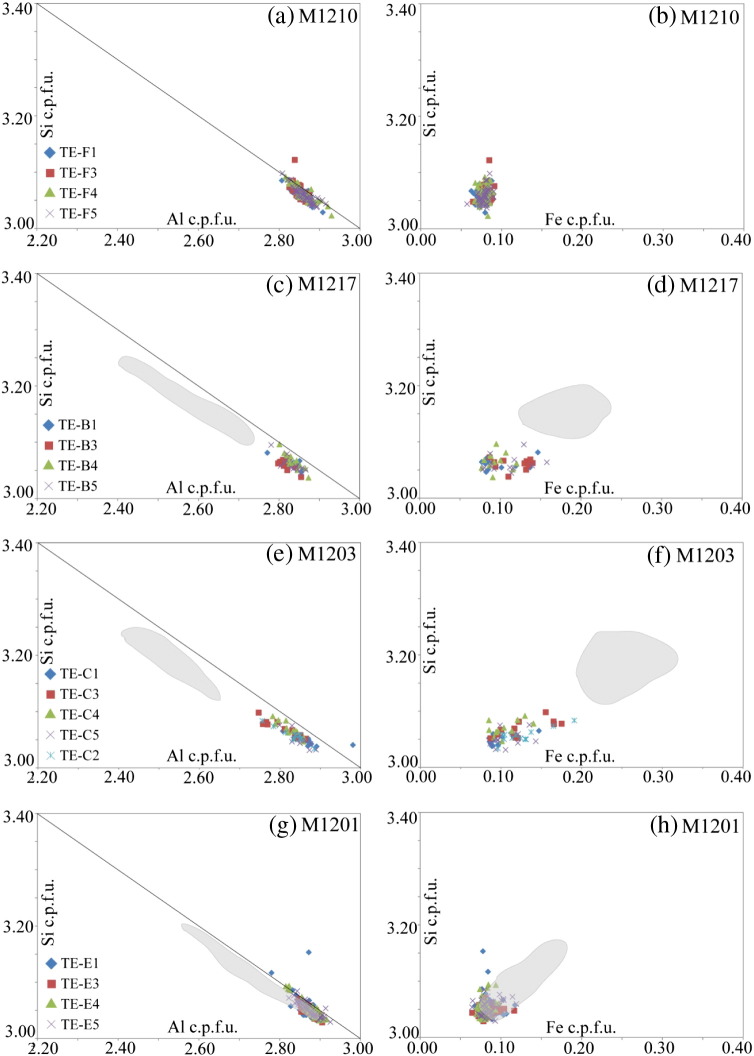
EMPA compositional data of embedded muscovite separates of Wm I used for Rb/Sr ID-TIMS analysis of (a–b) M1210, (c–d) M1217, (e–f) M1203 and (g–h) M1201. Grey areas limit the compositional range of Wm II and Wm III determined by EMPA from thin sections of rock chips. Note the overlap of this field with data from Wm I separates in M1201 (g–h) (cf. Fig. 4). Sample HM00305 was not analysed as the separated Wm I did not provide enough material for an additional aliquot. See text for discussion.